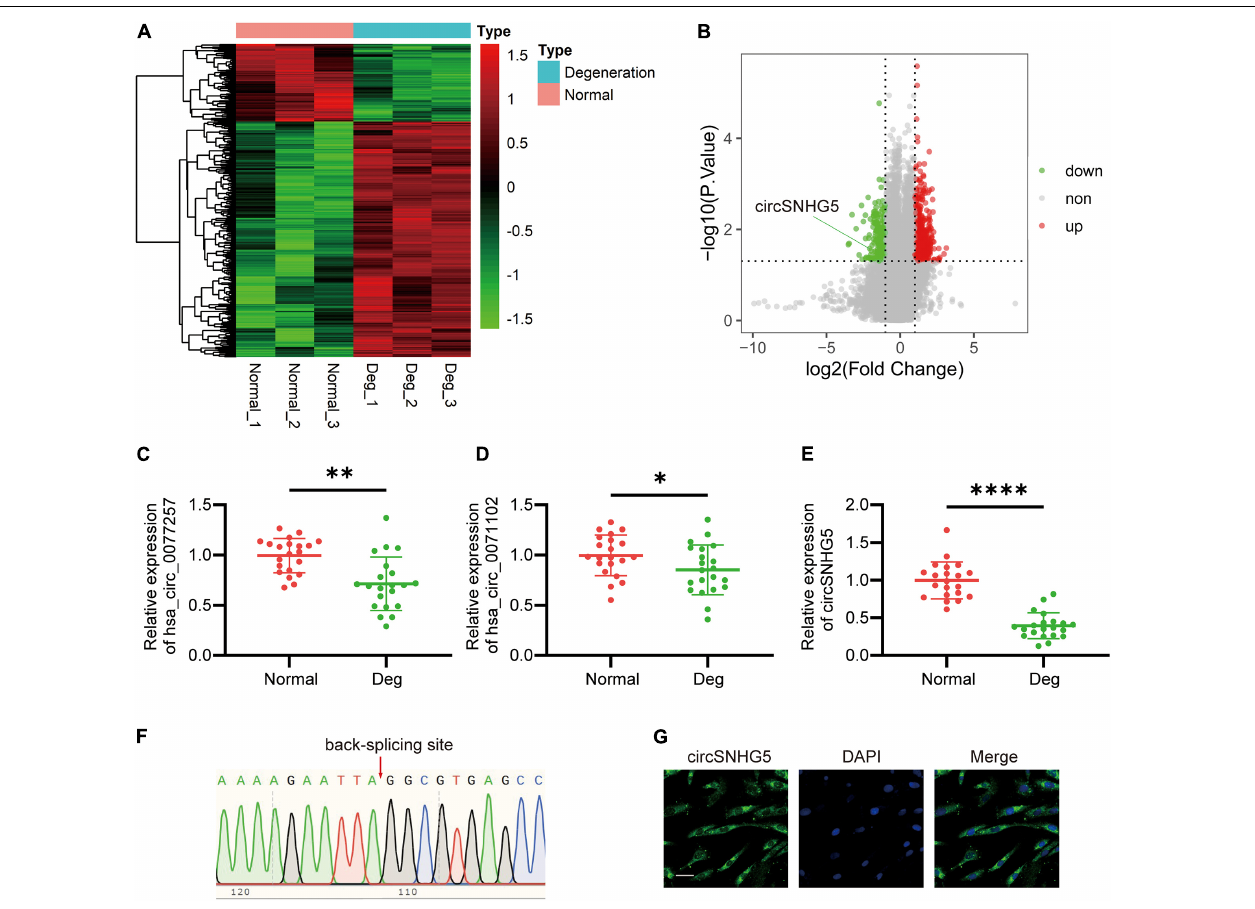
FIGURE 1 | circSNHG5 expression is downregulated in degenerative cartilage endplate (CEP) tissues and predominantly localized in the cytoplasm. (A) Heat map of differentially expressed circRNAs with fold changes (absolute value) > 2 and P -value < 0.05 between the two groups. (B) Volcano plots show circRNAs differentially expressed; upregulated in red, downregulated in green. (C–E) The expression of hsa_circ_0077257, hsa_circ_0071102, and circSNHG5 in different CEP tissues of 21 patients and 21 control samples ( ∗ P < 0.05, ∗∗ P < 0.01, and ∗∗∗ P < 0.001). (F) Sanger sequencing confirmed the back-splice junction sites of circSNHG5. (G) RNA FISH showed that circSNHG5 was predominantly localized in the cytoplasm. circSNHG5 probes were labeled with Alexa fluor 488. The nuclei were stained with DAPI. Scale bar, 20 µ